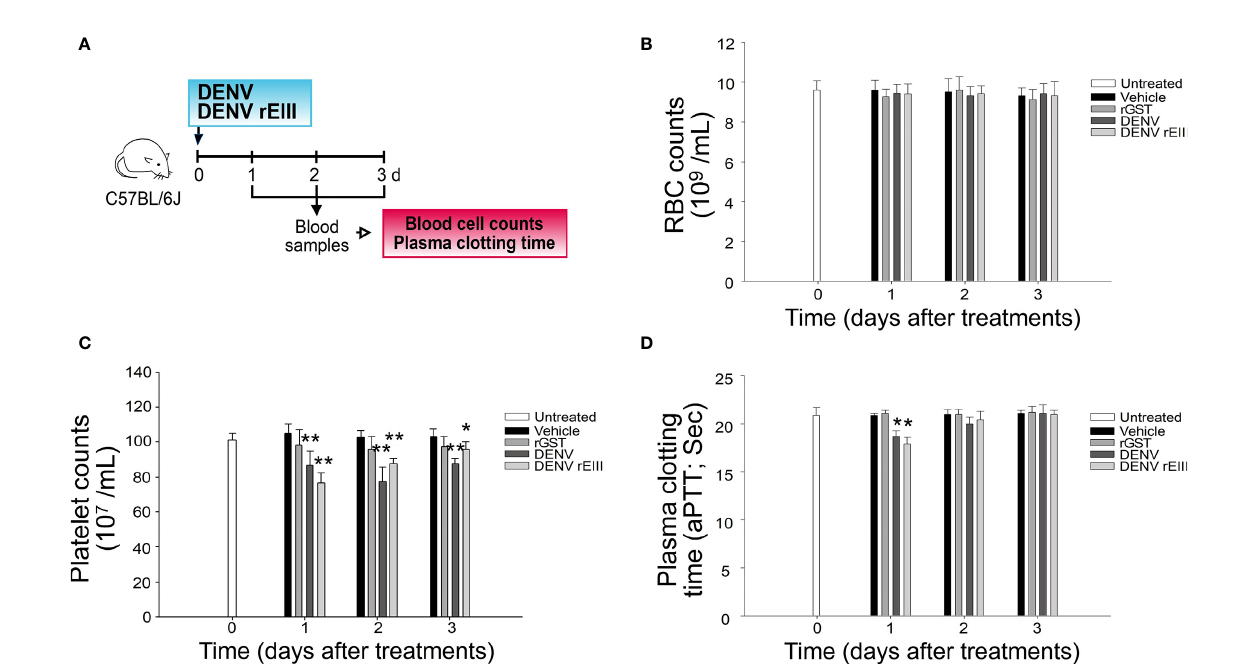
FIGURE 2 | Challenges of rEIII-induced thrombocytopenia and hypercoagulation in mice. (A) Experiment outline. (B) RBC counts, (C) platelet counts, and (D) aPTT measures 1-3 d after mice were exposed to DENV particles (1.2 × 10 7 PFU/kg; approximately 3 × 10 5 PFU/25 g mouse) and rEIII (2 mg/kg). Compared with rGST treatments, injections of both DENV and rEIII induced (C) thrombocytopenia and (D) hypercoagulation (shortened aPTT plasma clotting time) in mice. * P < 0.05, ** P < 0.01 vs. respective rGST groups; n = 6 (three experiments with two mice per group). The mouse drawing used in this and following fi gures was originally published in the Blood journal: Huang, H. S., Sun, D. S., Lien, T. S. and Chang, H. H. Dendritic cells modulate platelet activity in IVIg-mediated amelioration of ITP in mice. Blood, 2010; 116: 5002 – 5009. © the American Society of Hematology.